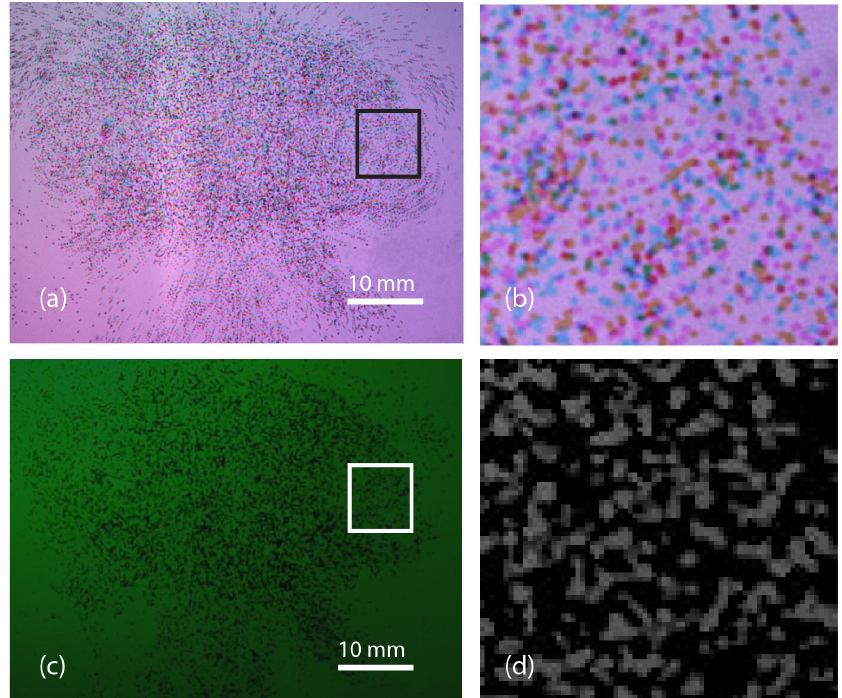
Figure 8. Raw images from the central camera (camera 3) of a vortex ring captured simultaneously by ( a ) a RED 4k video camera and ( c ) an Xperia TM smartphone. Panels ( b , d ) show the corresponding magnified regions marked in the respective squares in panels ( a , c ). One can note the difference in the resolution of the two systems. The viewing angles for ( a , c ) are slightly different. Therefore, the images are not fully